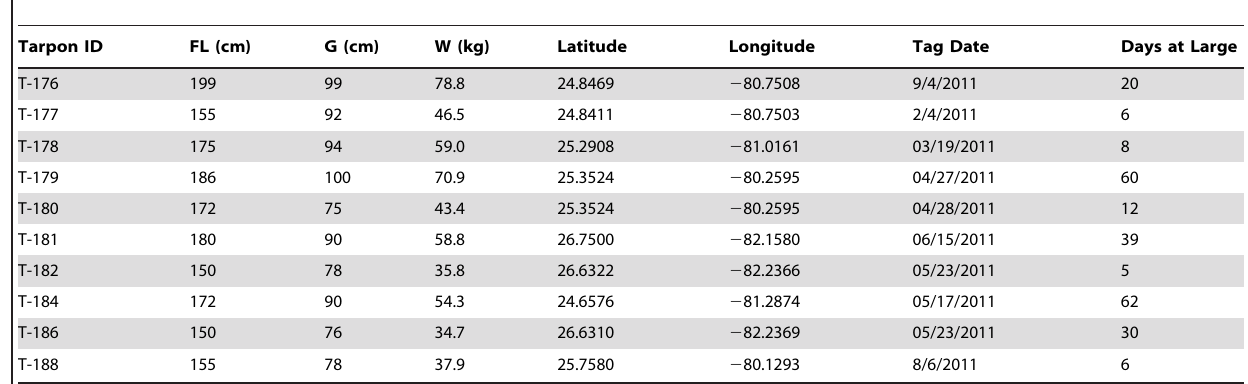
Table 3. Summary data for 10 Atlantic tarpon tracked with SPOT5